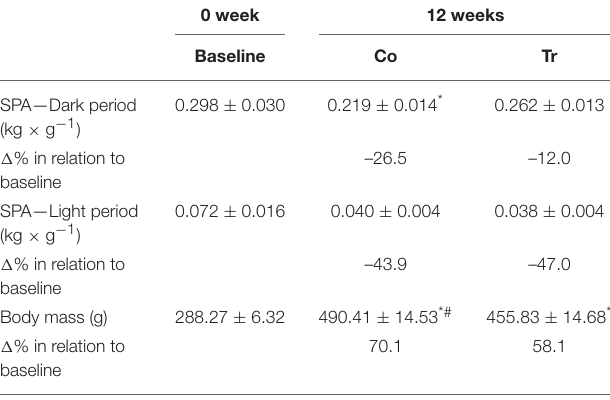
TABLE 1 | Spontaneous physical activity (SPA) during dark and light periods, and body mass for the baseline, control (Co) and training exercise (Tr)